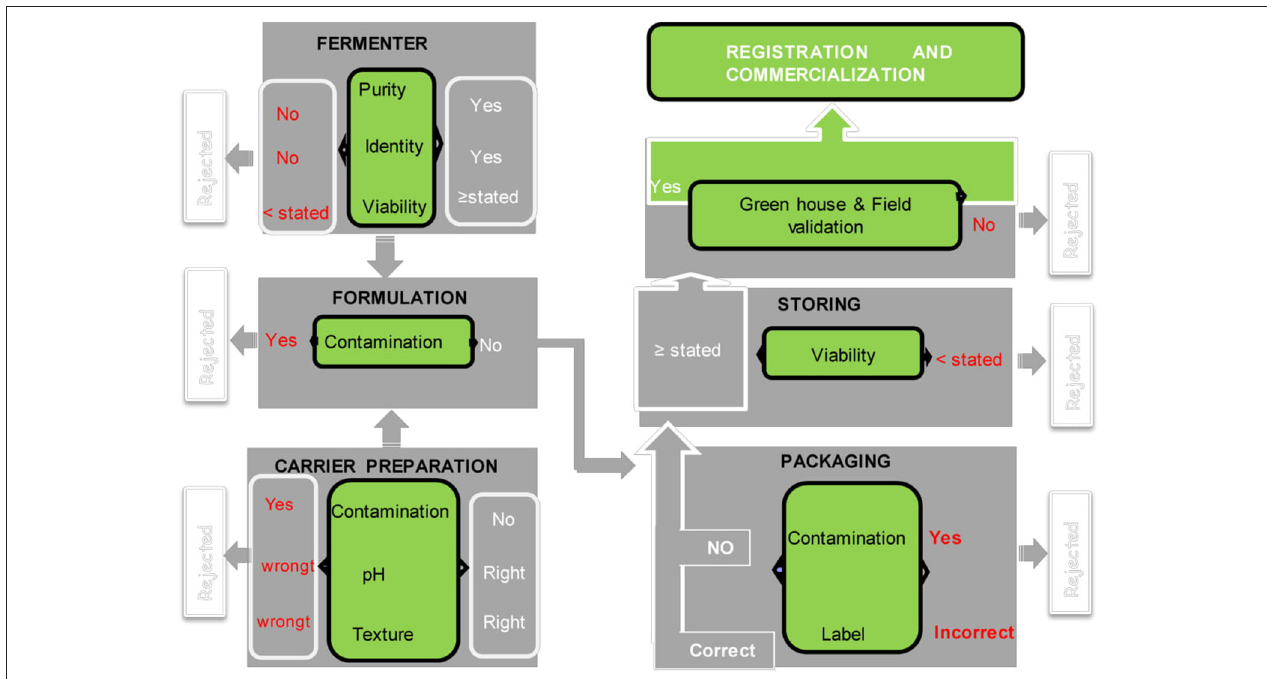
FIGURE 1 | Quality control in the biofertilizer manufacturing process [modified from García-Fraile et al. (2015), Permission acquired from the author]. Writing in red means that the quality control is not compliant, and the project is rejected the writing in white corresponds to the compliant product. The diagram shows that bio-formulation has six main steps before commercialization and four each stage, a quality control is